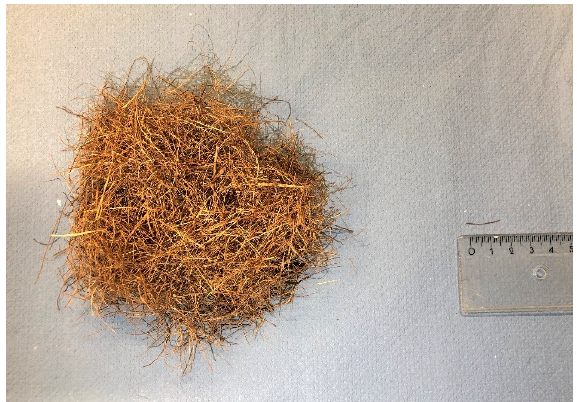
Figure 3. SEM pictures of outer surface and inner porous structure of LWAs: ( a ) LWA-3, ( b ) 0.5–1.0 mm.